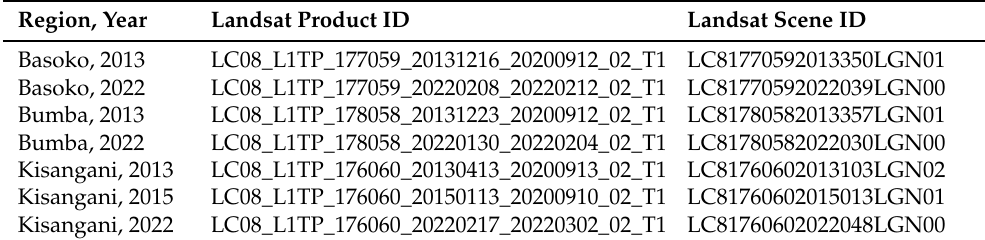
Table 1. Landsat-8 OLI / TIRS Product ID and Scene